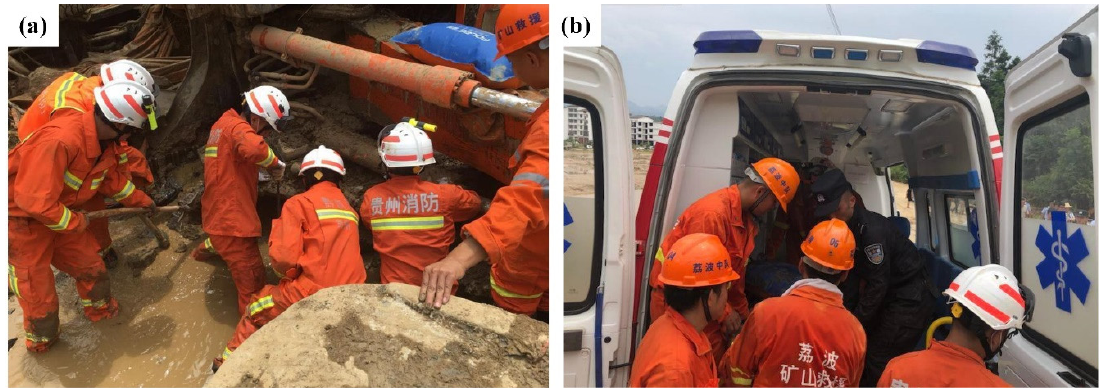
Figure 4. Joint rescue activity: ( a ) Firefighters searching for victims; ( b ) emergency treatment (Picture source: http://m.news.cctv.com/2018/06/11/ARTI6F58tT5PonH5KXoex9X5180611.shtml).